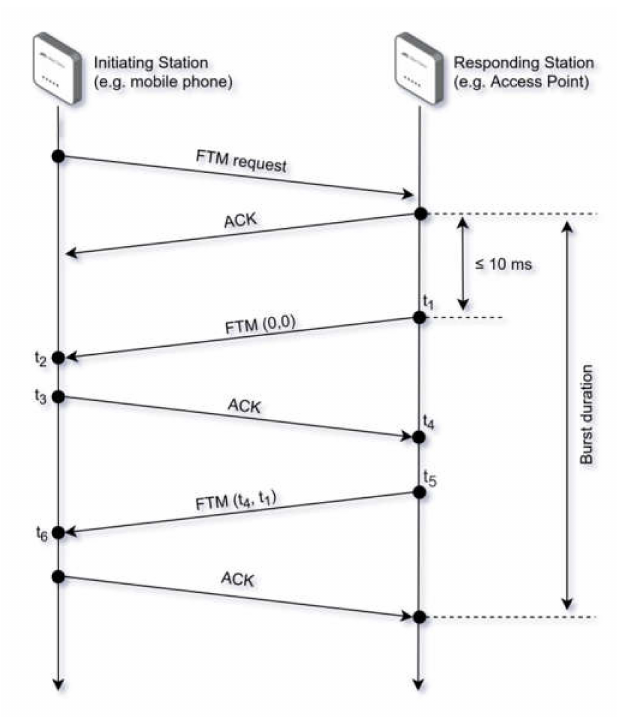
Figure 1. Basic procedure to gather round trip time (RTT) measurements in IEEE